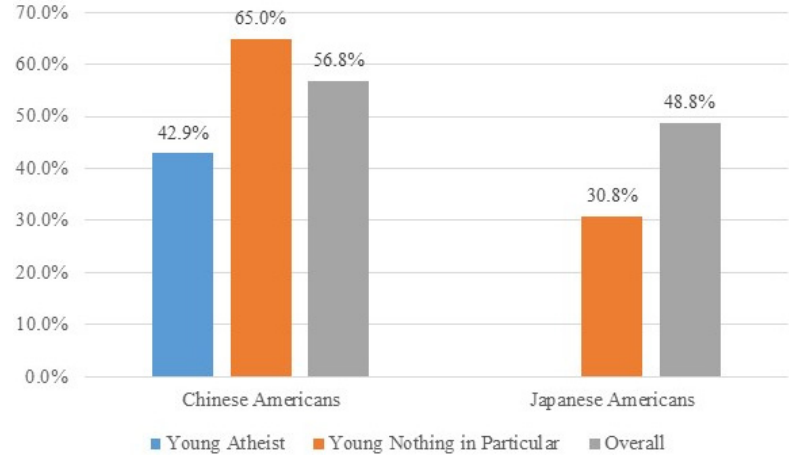
Figure 16. Values parental influence in spousal choice.